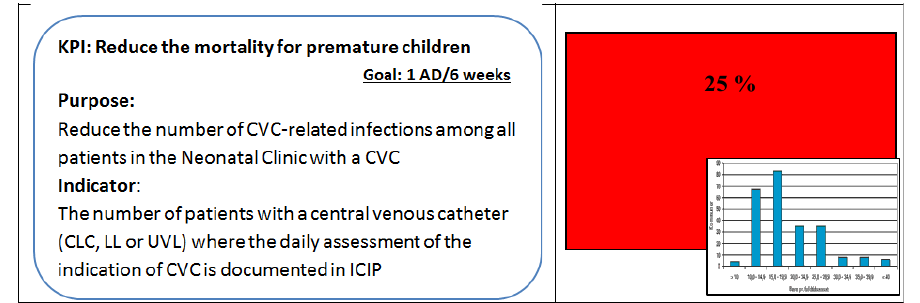
Figure 7. A whiteboard objective. Source: A zoomed in image of Figure 2